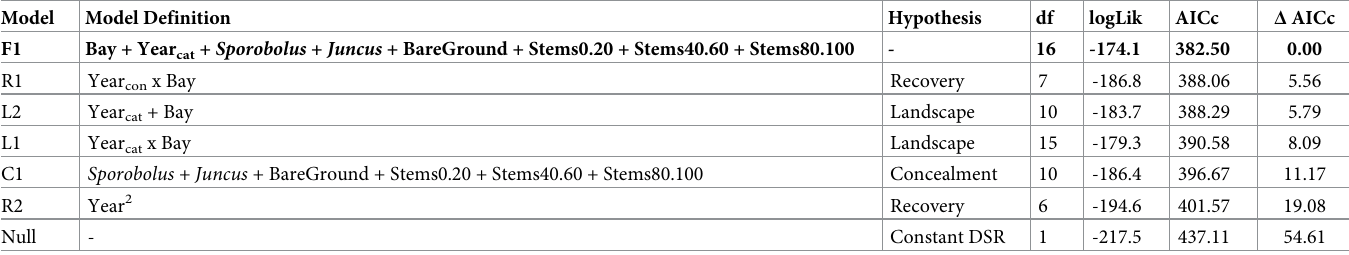
Table 2. Description and evaluation of six logistic exposure models explaining variance of Daily Survival Rates (DSR) of Seaside Sparrow nests in Louisiana, USA 2012–2017.